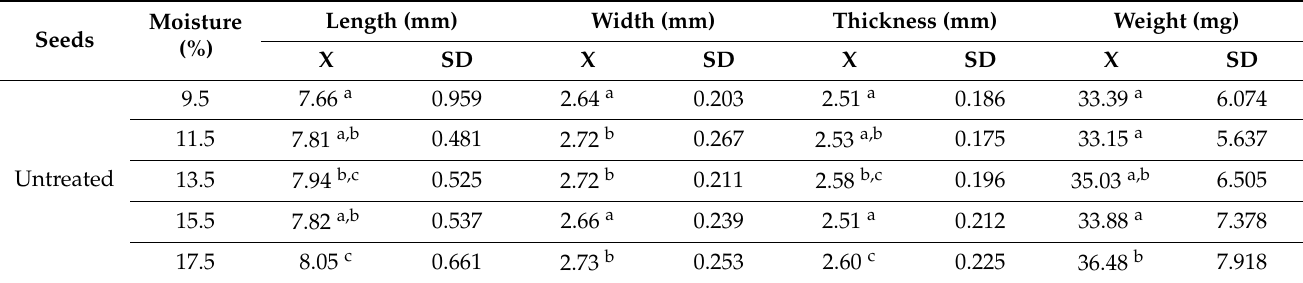
Table 3. The statistical parameters of the physical characteristics of winter rye